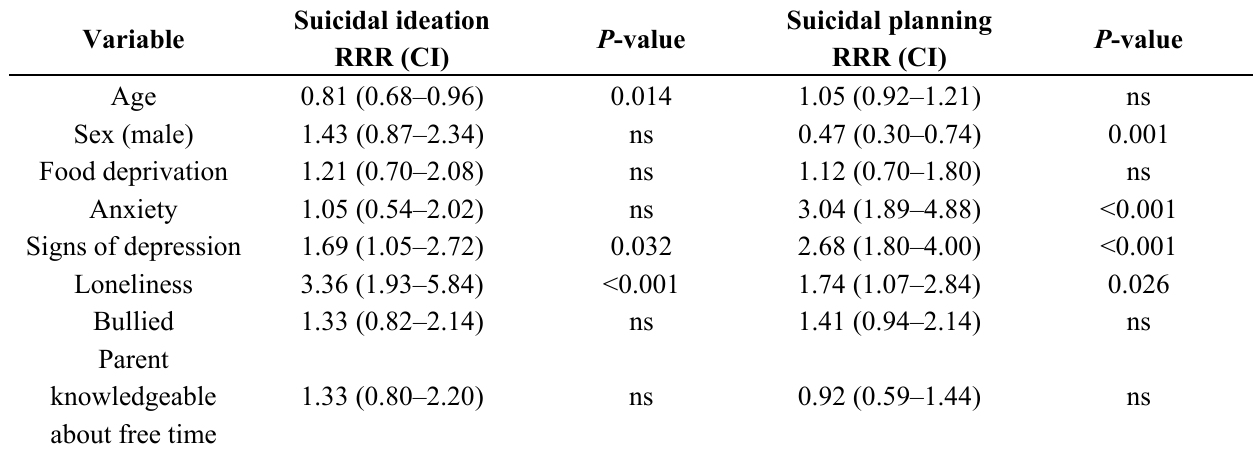
Table 2. Multivariate analysis of suicide ideation and planning among school-attending adolescents in the